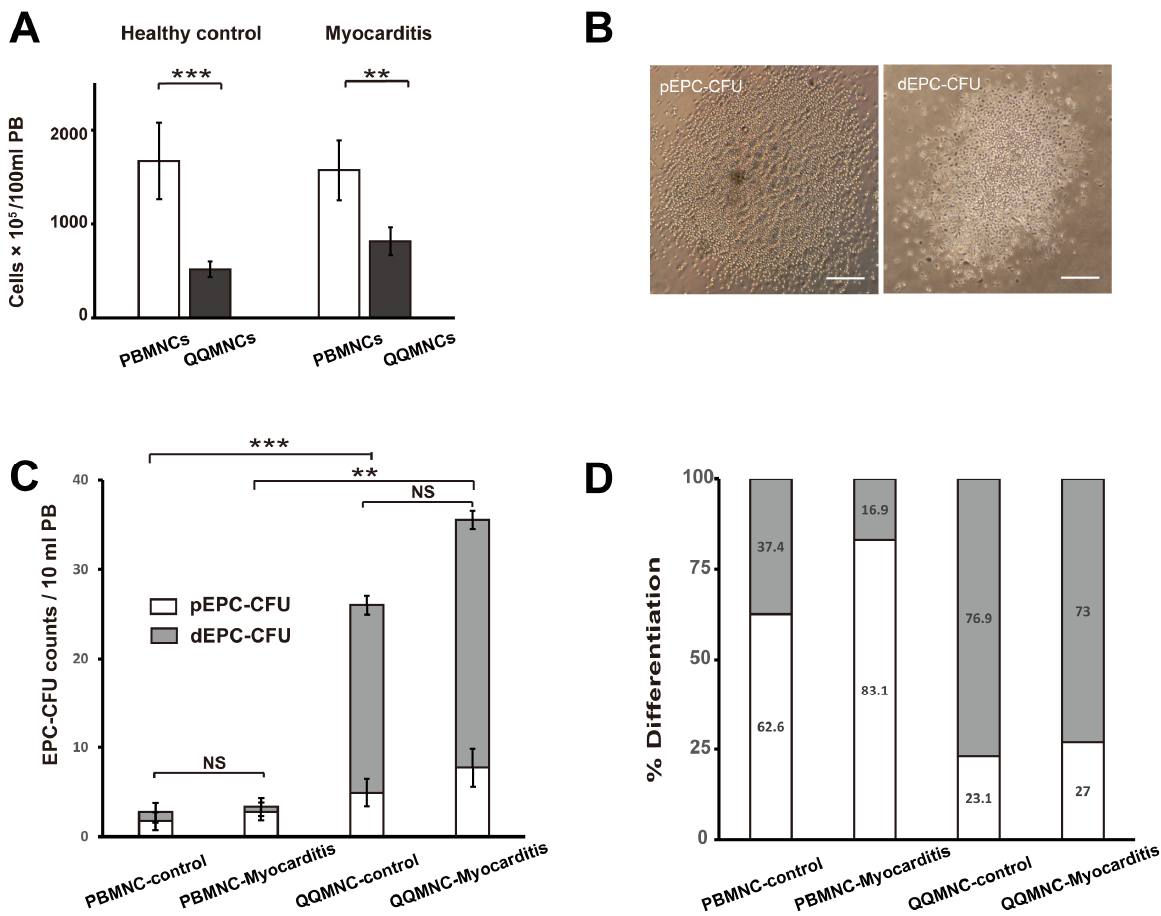
Figure 2. QQ culture in healthy control and rats with myocarditis. ( A ) The graph shows the total cell number of PBMNCs and QQMNCs isolated from 100 mL of peripheral blood. Cell counts showed significant differences between PBMNCs and QQMNCs derived from healthy controls and rats with myocarditis. Cell counts showed no significant difference in QQ culture between healthy controls and rats with myocarditis. Data are shown as the mean ± SE. N = 7 to 8. ** p < 0.01, *** p < 0.001, NS: not significant. ( B ) Representative picture of pEPC-CFU and dEPC-CFU in rats with myocarditis. Scale bar = 500 µ m. ( C ) The graph shows EPC-CFU counts generated from PBMNCs and QQMNCs per 10 mL of peripheral blood in healthy controls and rats with myocarditis. Comparative analysis showing an increased number of EPC-CFU in QQMNCs of rats with healthy controls and myocarditis. ( D ) The graph shows pEPC-CFU and dEPC-CFU counts as a percentage of total EPC-CFU count per dish. Data are shown as mean ± SE. N = 6. ** p < 0.01, *** p < 0.001.